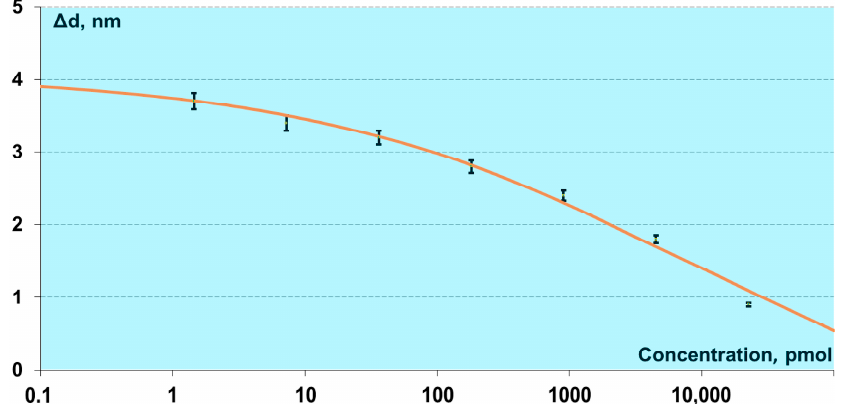
Figure 6. Calibration curve for the SCI-based method of folic acid detection as a dependence of variation of the biolayer thickness upon concentration of folic acid antigen in the analyzed sample (at the FA antibody concentration of 7 µg/mL). FA concentrations in the samples were as follows: 22,650 pM, 4500 pM, 900 pM, 180 pM, 36 pM, 7.2 pM, and 1.4 pM. These data points represent mean values (n = 3), and the error bars show standard deviations. The solid line exhibits fitting with a 5-parameter logistic curve.